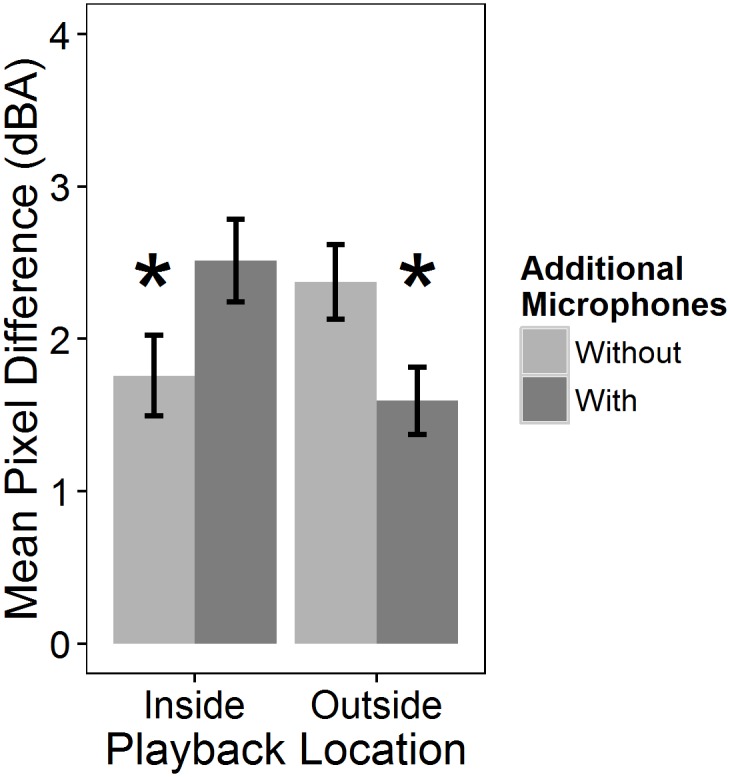
Effect of additional microphones on differences between maps depended on location of noise introductions.Mean pixel difference is the average difference in overall sound pressure levels (dBA) calculated by subtracting a subset map from the corresponding full array map and averaging overall all pixels. The asterisk denotes a significant difference as tested using Tukey HSD (P < 0.05). Error bars represent standard error.